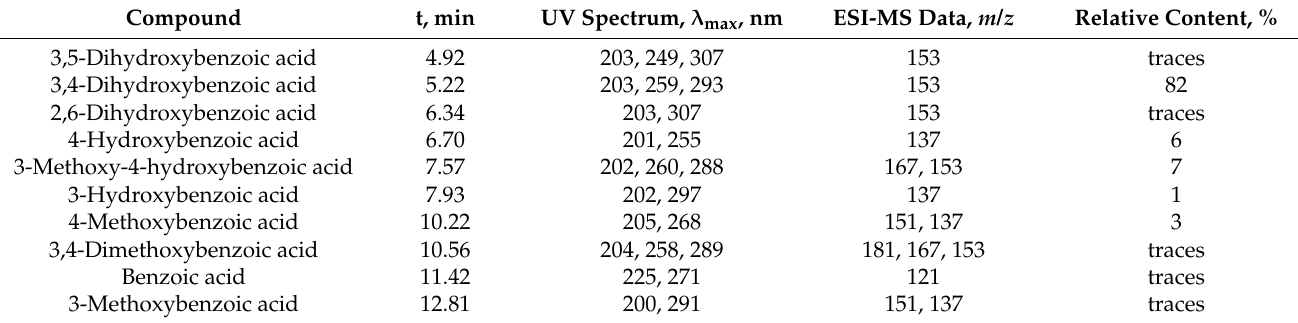
Table 5. The retention times (t), UV, mass spectral data, and relative content of cleavage compounds after the alkaline destruction of E. angustifolium